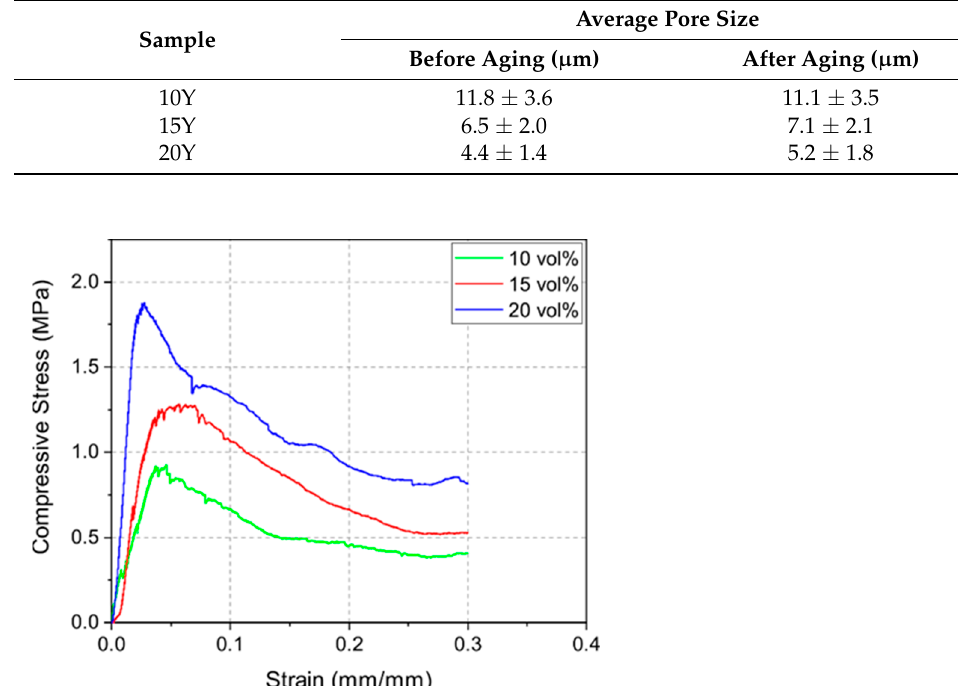
Table 3. Summary of pore size measurements determined from SEM images before and after thermal aging at 1400 ◦ C for 96 h.